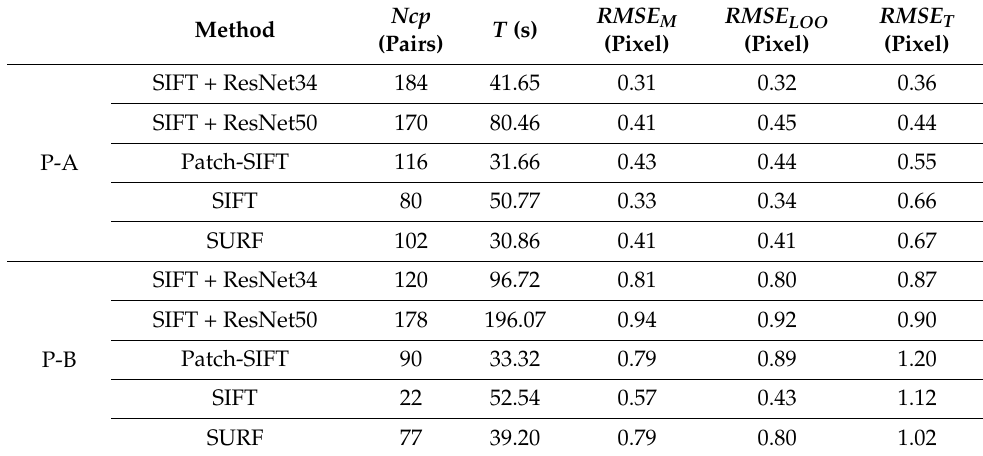
Table 4. Registration results for GaoFen multispectral